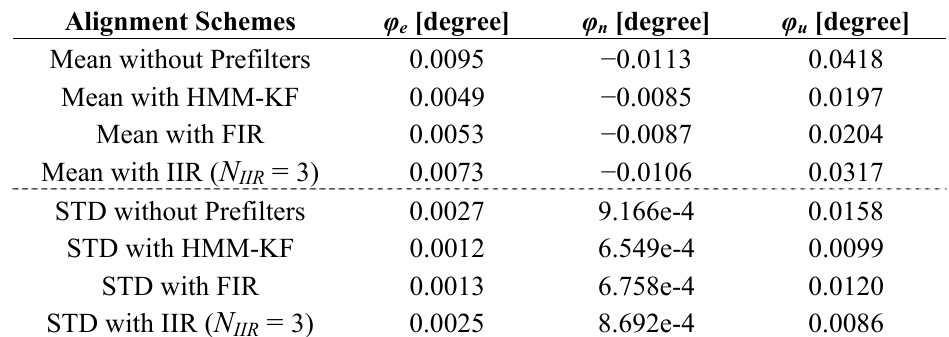
Table 9. Mean and STD of the misalignment angles using the four alignment schemes. Alignment